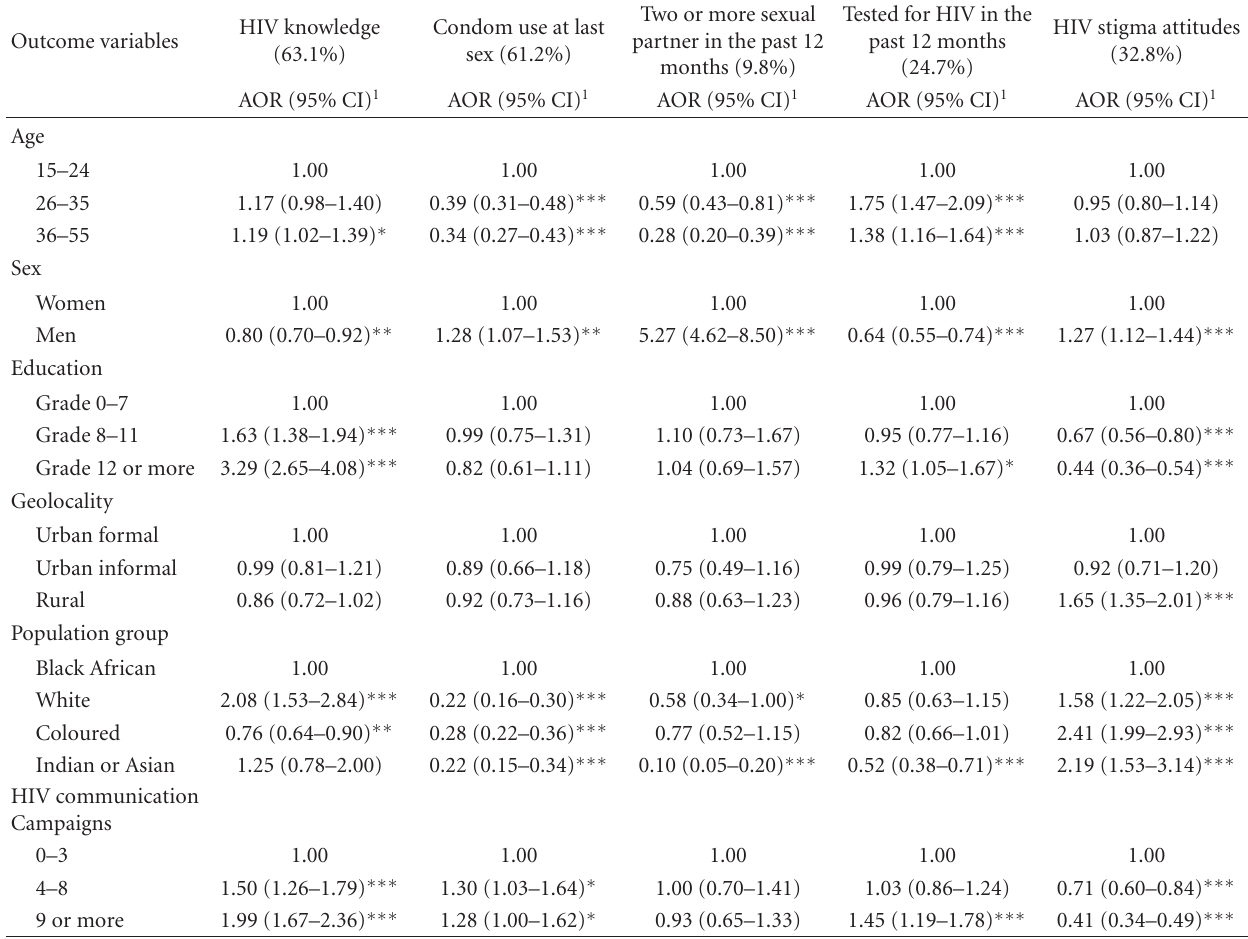
Table 4: Association between HIV communication campaigns and outcome